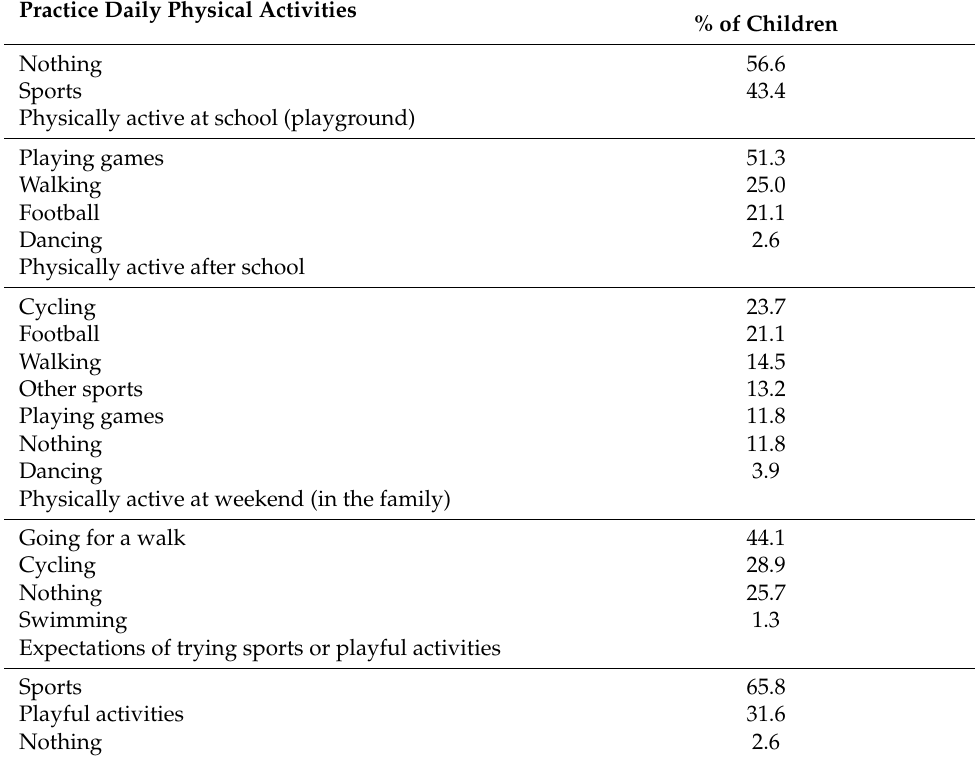
Table 6. Frequency distribution of children practising sports or playful activities